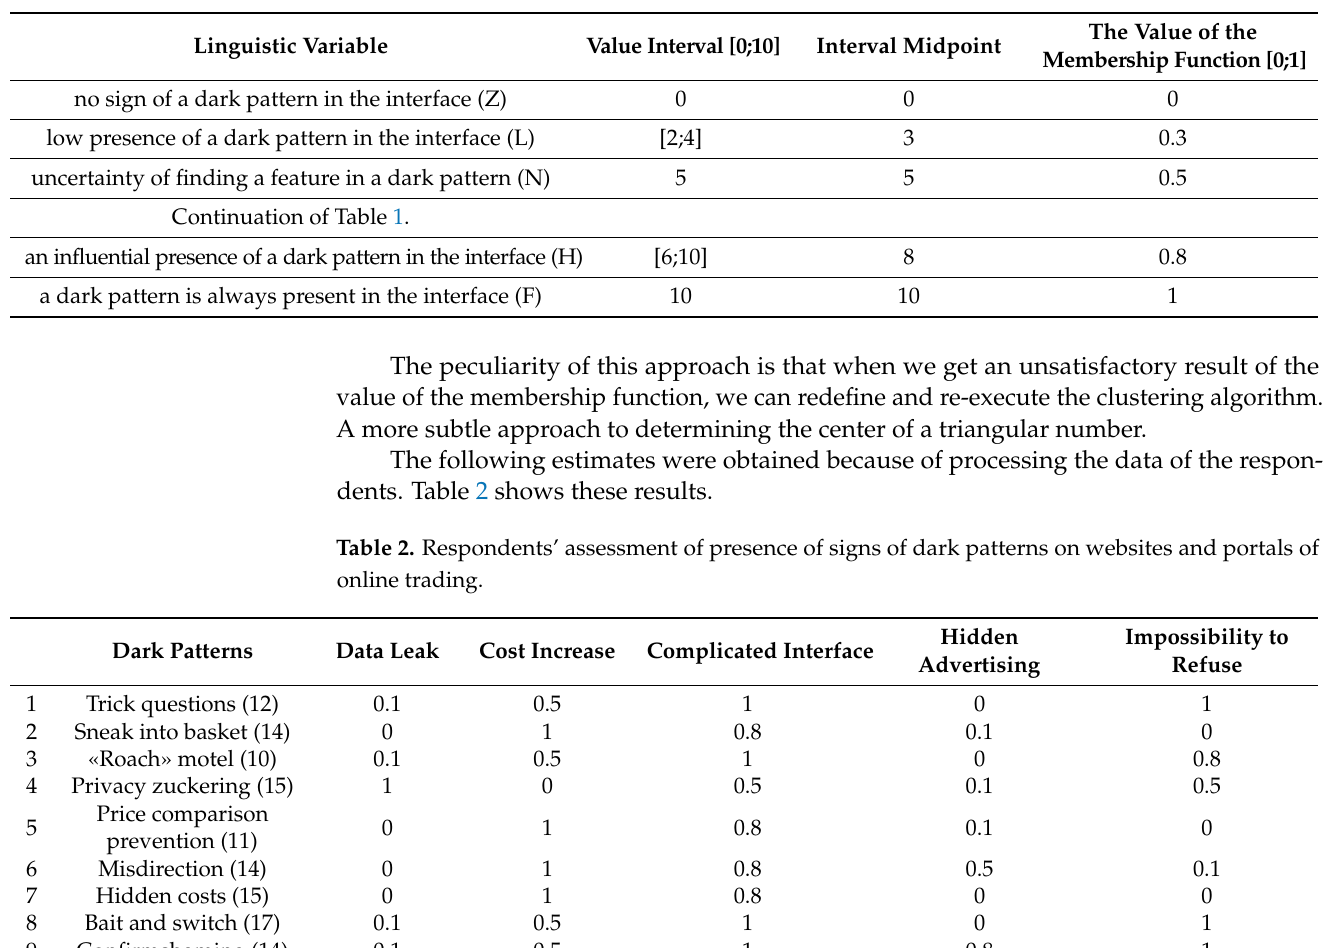
Table 1. Numerical values of linguistic variables of the interval scale.